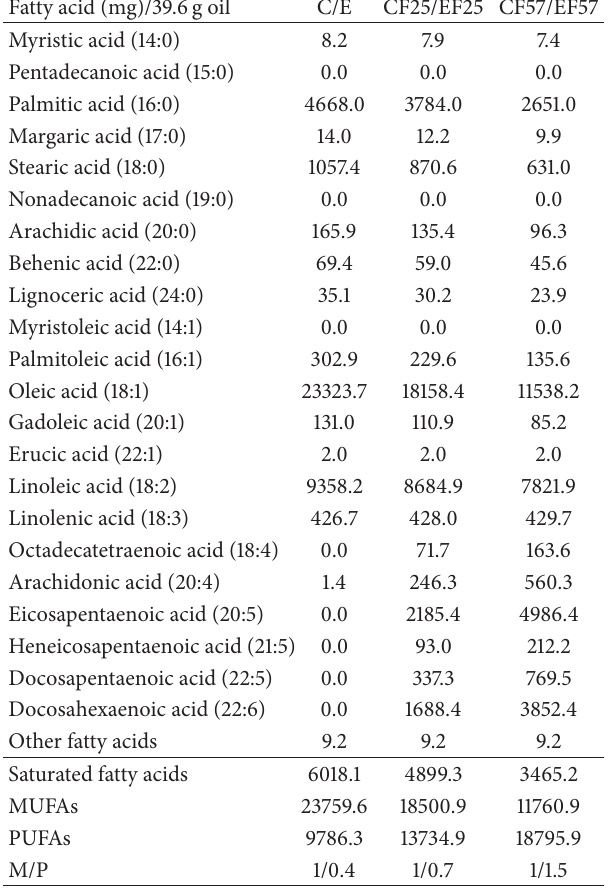
Table 2: The fatty acid compositions of the experimental diets 1,2,3 . Fatty acid (mg)/39.6 g